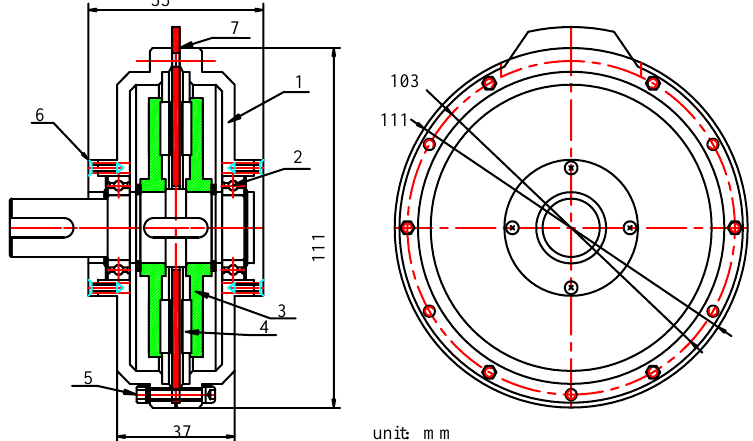
Figure 1. Structure diagram of prototype of a printed circuit board (PCB) stator disc-type motor. (1) ends cap; (2) bearing; (3) back iron; (4) permanent magnet (PM); (5) hexagonal nuts; (6) cross sunk head screw; (7) PCB board.